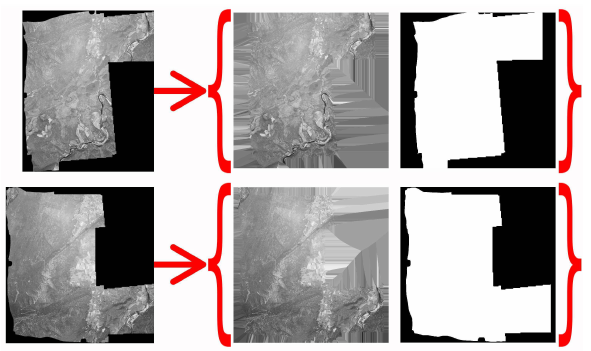
Figure 6: Two extrapolated images with their associated mask The extrapolation is justified by the fact that using directly the images with their mask would follow some irrelevant KLT basis illustrated in Appendix A.